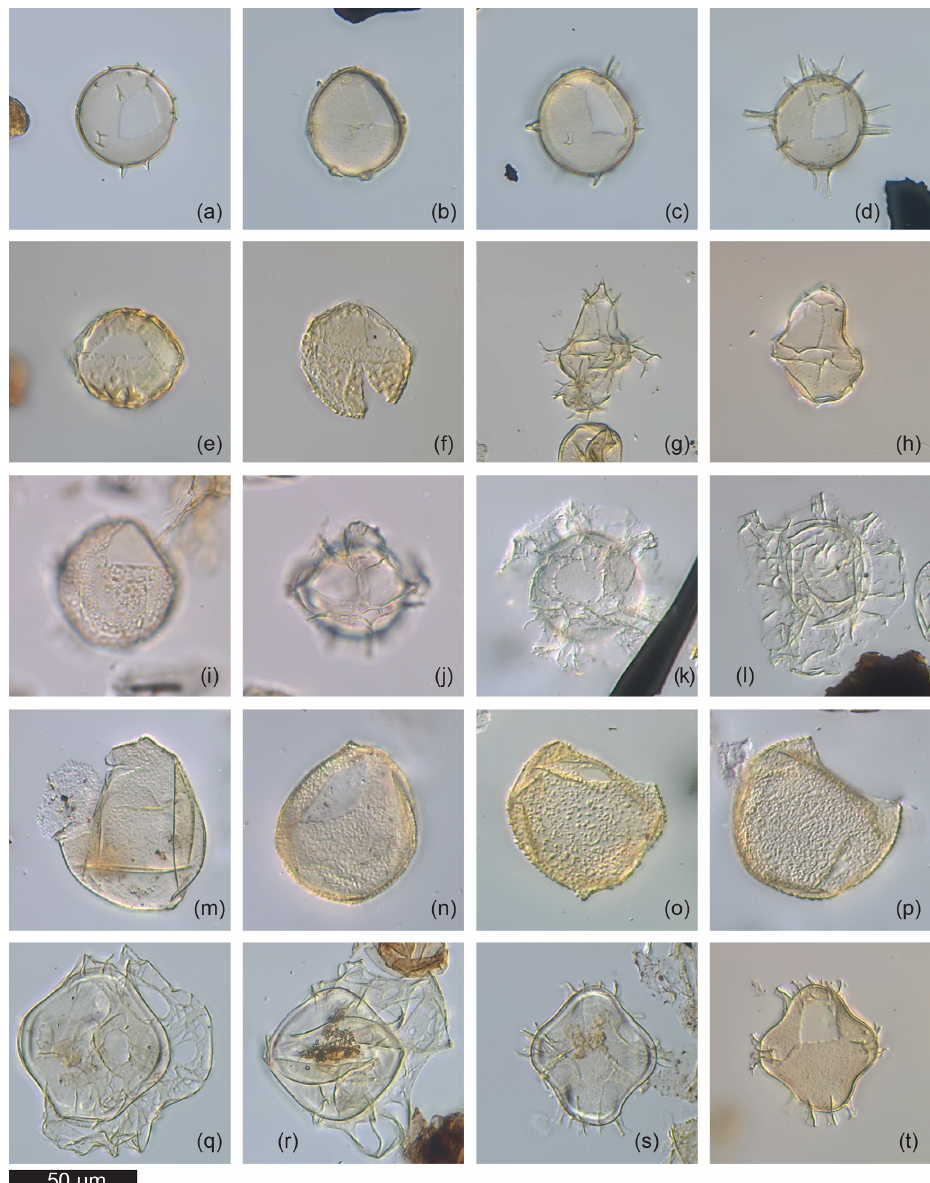
Figure 1. Examples of the morphotypes observed during the current study by transmitted light microscopy. Sample codes give core number (first number), section number (second number), depth within core (third number, in centimetres) and depth of the middle of the sam- ple in metres below sea floor (mb.s.f.). (a) “ Pyxidinopsis psilata ? var. A” but with incipient process formation (29-R-1-W,